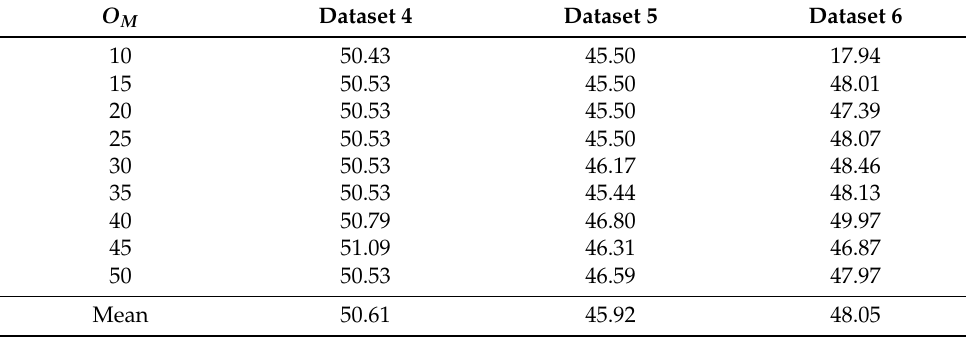
Table 7. Optimization experimentally obtained results for O M .